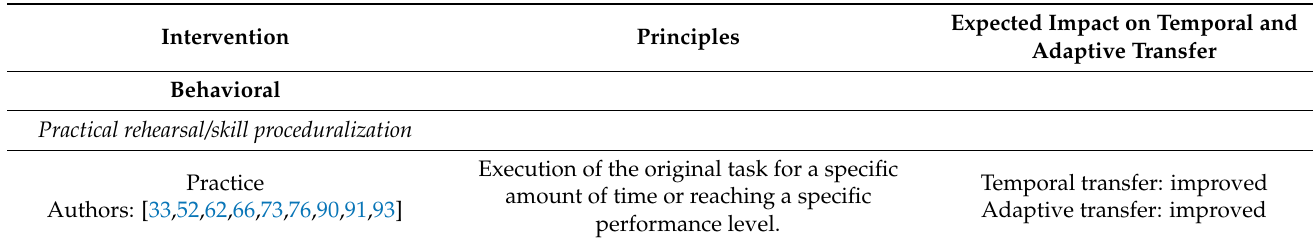
Temporal transfer: improved Adaptive transfer: